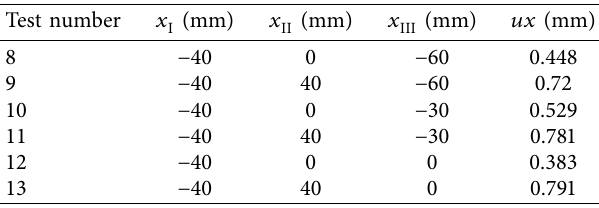
Table 11: Influence of the interaction support I × II on vibration displacement.